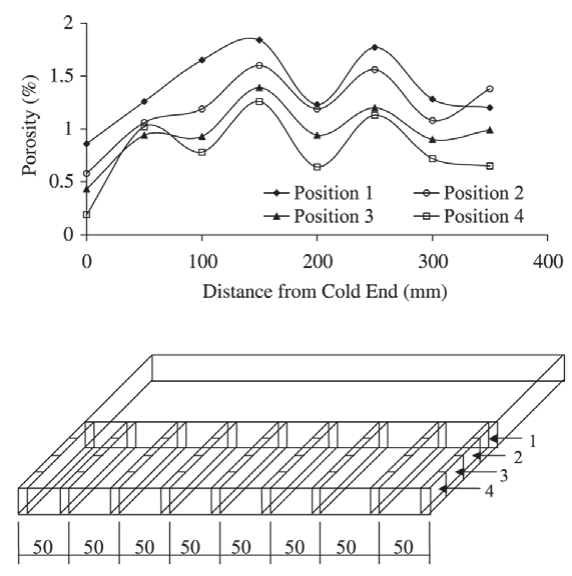
Figure 9. Volumetric distribution of porosity on the plate.